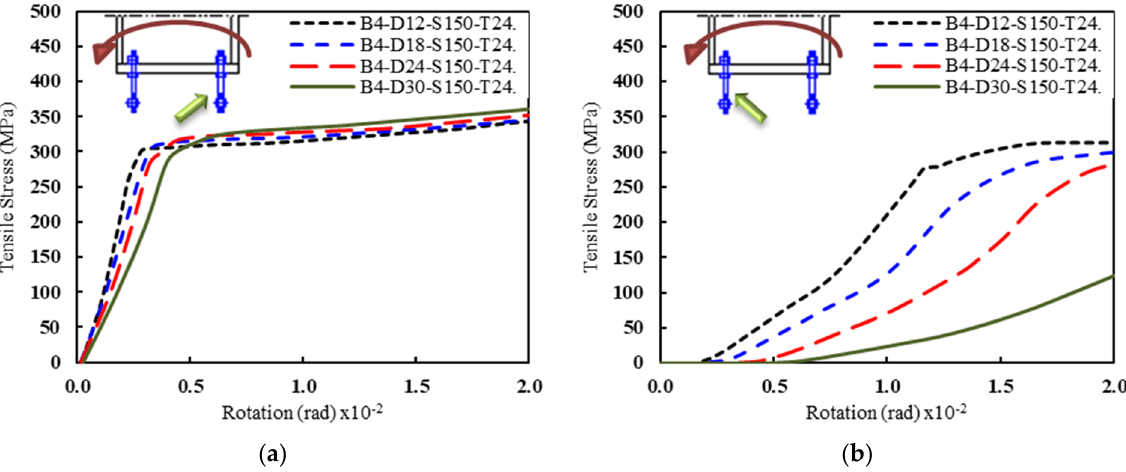
Figure 19. Tension force in the anchor bolts vs. rotation: ( a ) anchor bolts in the tension side, and ( b ) anchor bolts in the compression side.